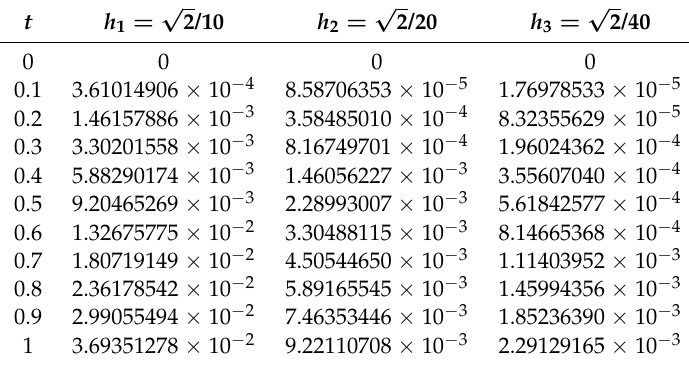
and α = 0.7 for Example 1000